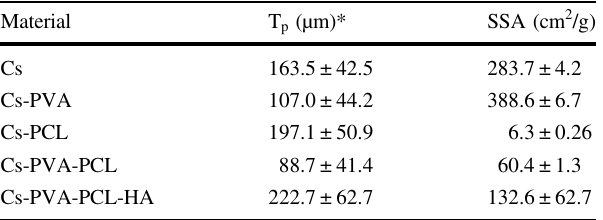
Table 1 Average pore size (T p ) and speci fi c surface area (SSA) of 3D- materials Material